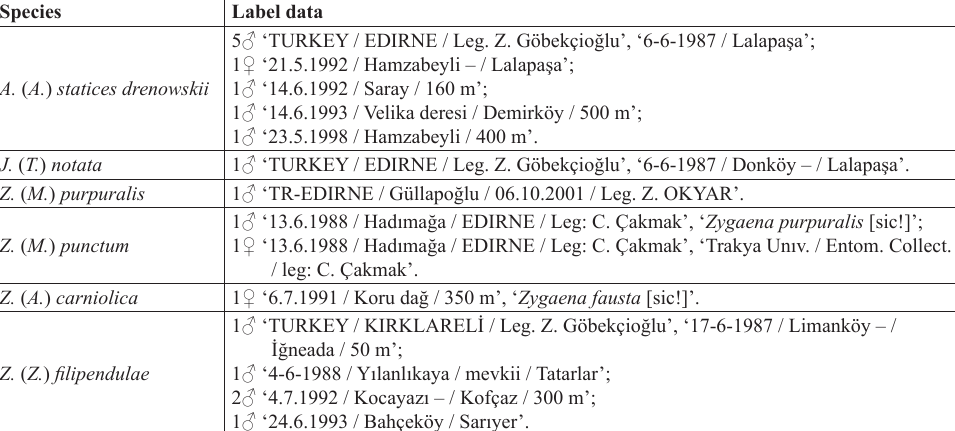
Table 4. Zygaenidae species from the Thrace Region in the collection of Mustafa Kemal University (Antakya, Hatay, Turkey) collected before 2016.